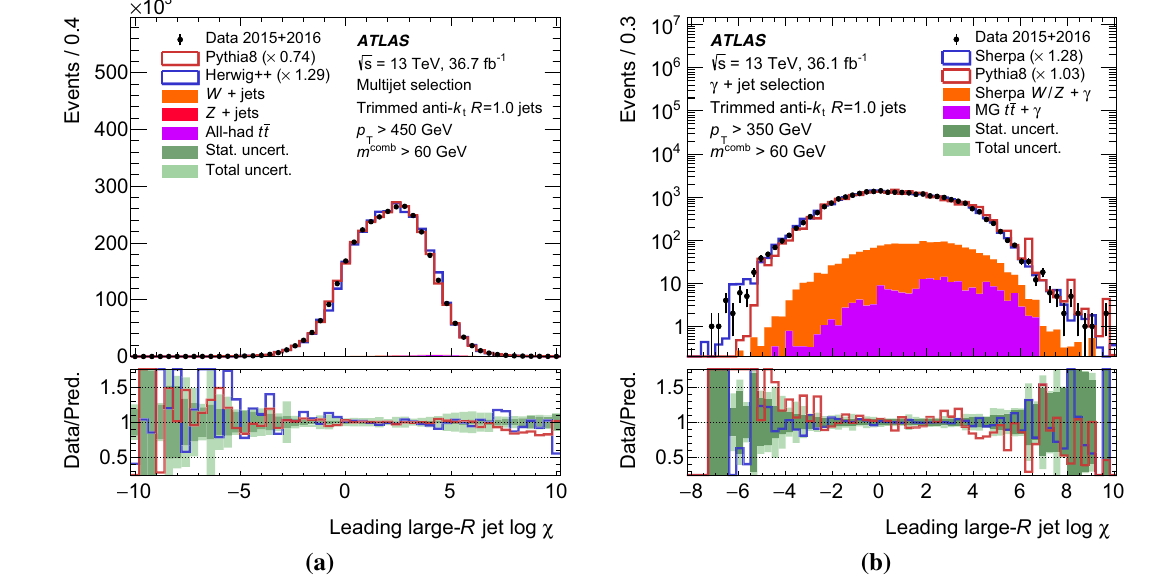
the legend beside the specific sample to which it applies. Systematic uncertainties are indicated as a band in the lower panel and include all experimental uncertainties related to the selection of events, as well as the reconstruction and calibration of the large- R